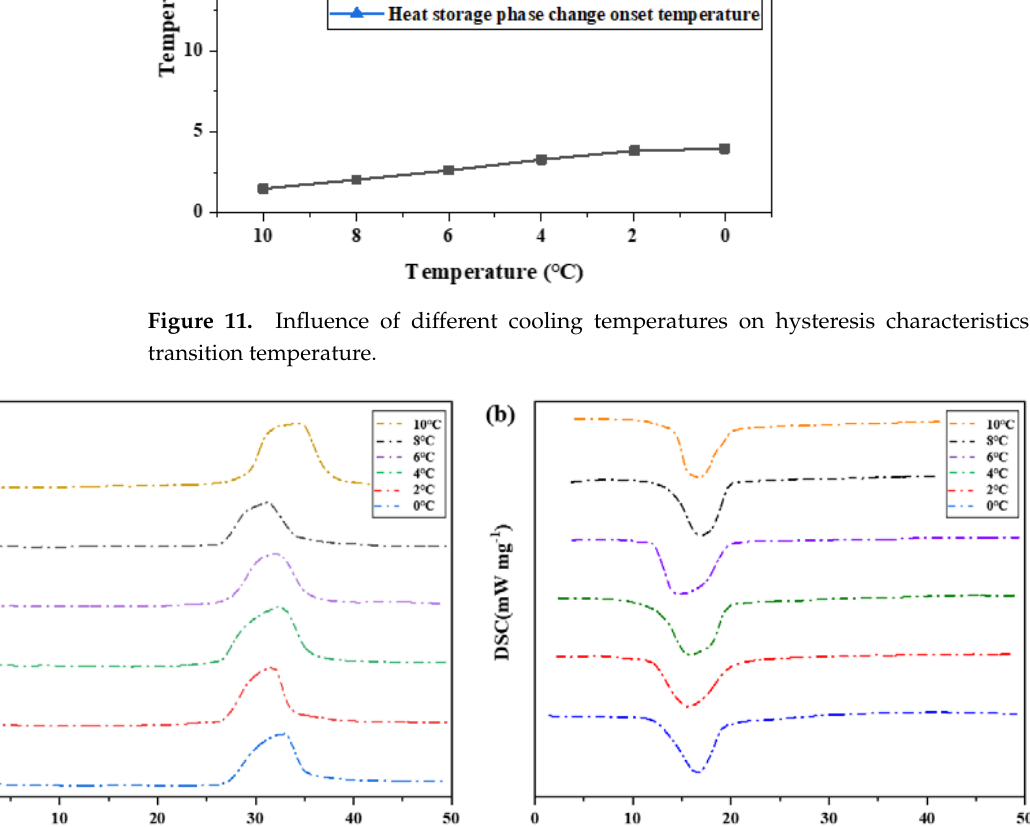
Figure 11. Influence of different cooling temperatures on hysteresis characteristics of phase transi- tion temperature.